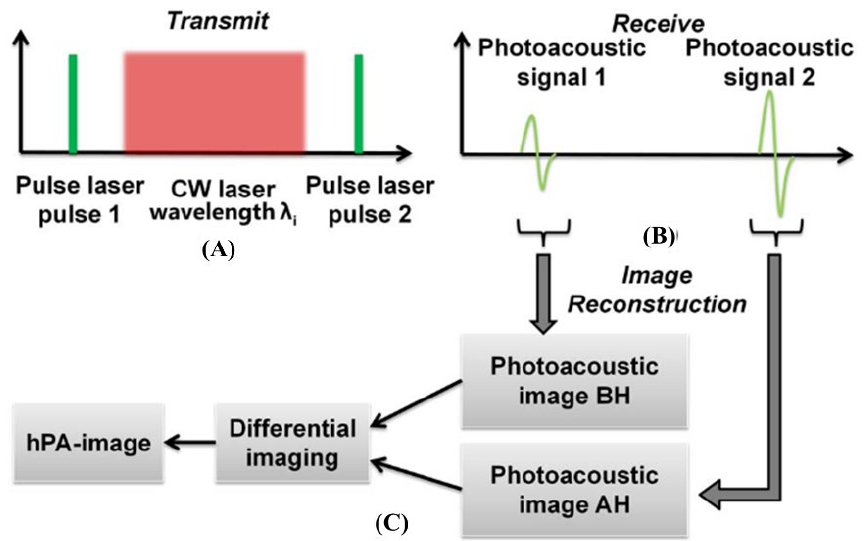
Figure 27. The image reconstruction process of proposed hybrid multi-wavelength PA imaging (hPAI) system. ( A ) Transmitted signal pattern, including two excitation pulses before and after CW laser illumination. ( B ) Received PA signals. ( C ) Image reconstruction process, including PA imaging before and after CW laser heating and hPAI obtained by applying differential imaging. Reprinted from Duan et al., Opt. Lett., 2018, 43, 22; 5611–5614 [45], with permission from the Optical Society of America.